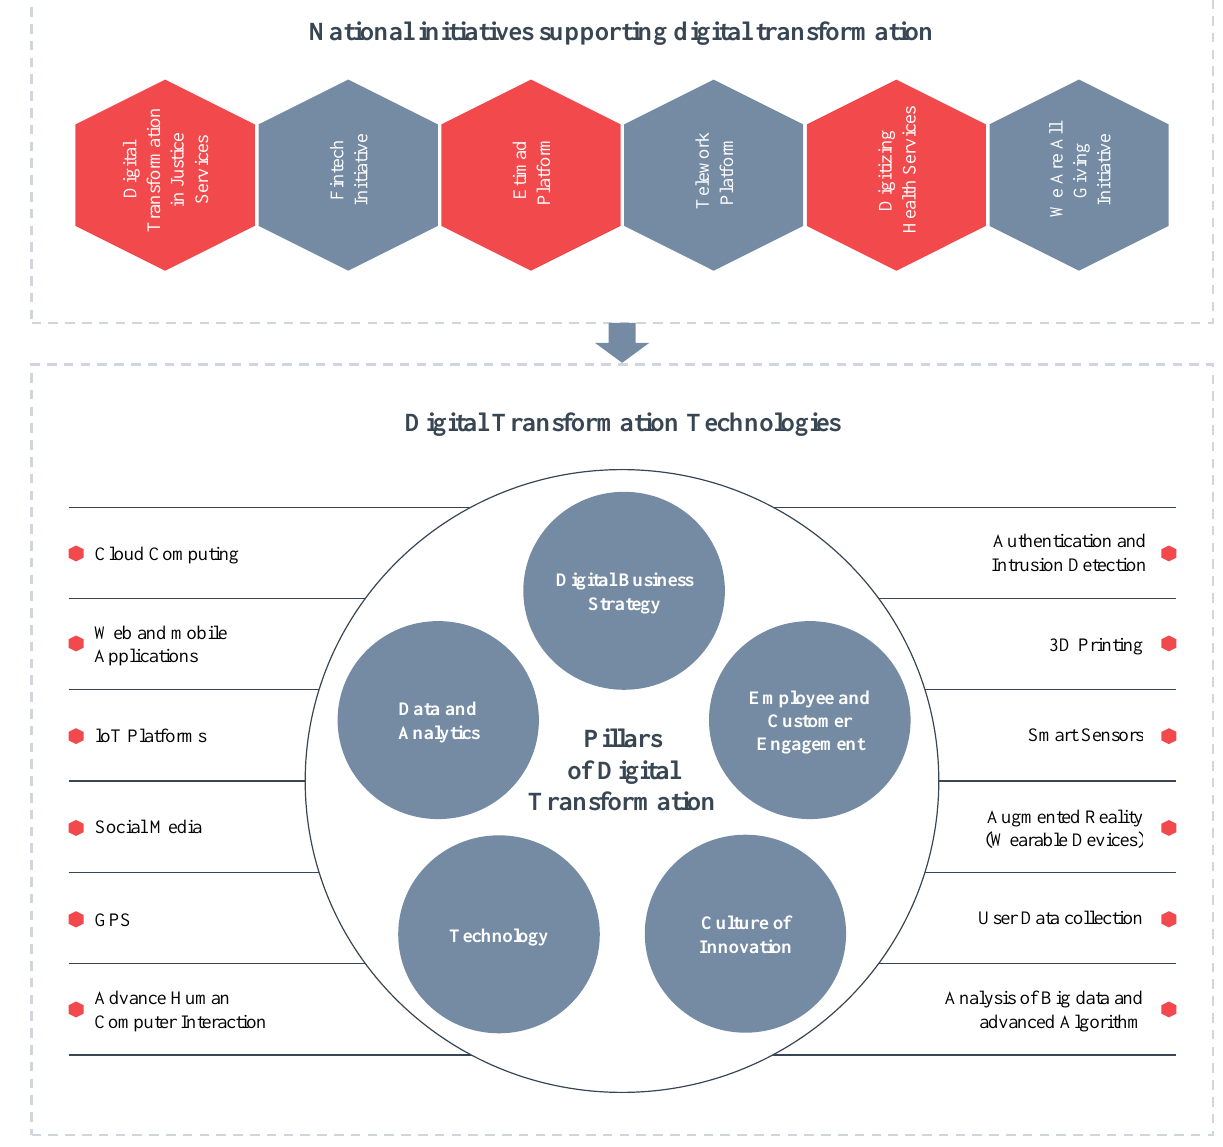
Figure 2. Pillars, initiatives, and technologies of